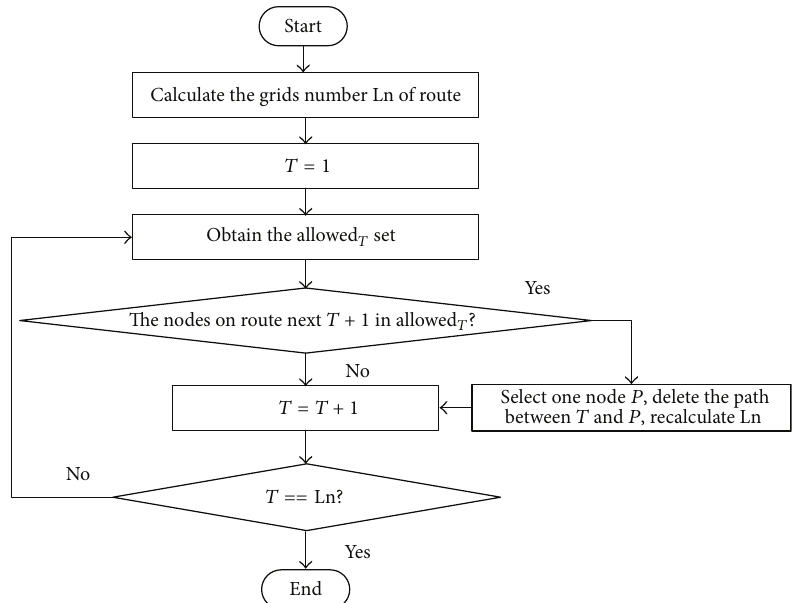
Figure 6: Flow chart of abandoning the roundabout.